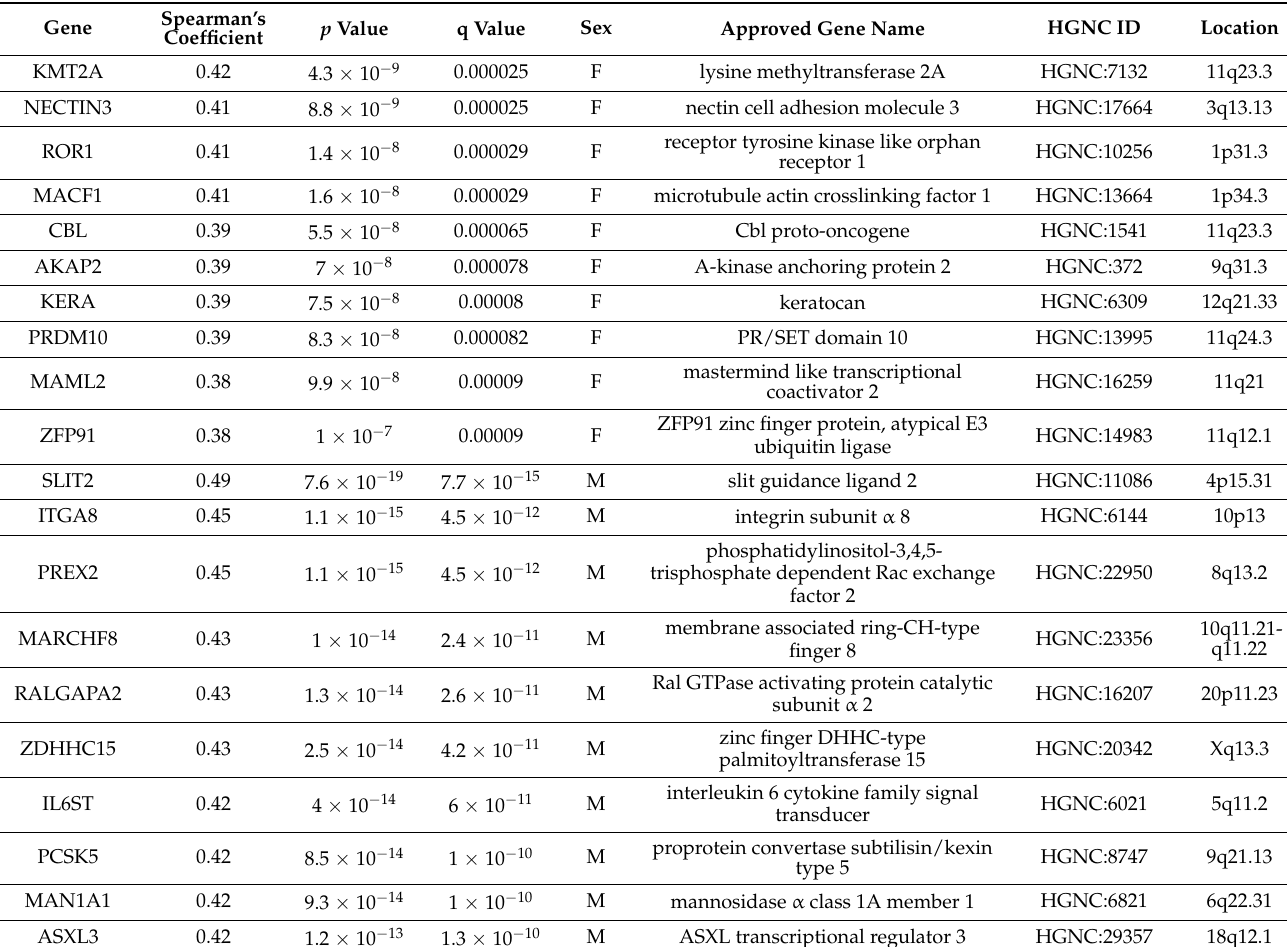
Table 5. Top 10 most significant sex-specific AR co-expressed genes in